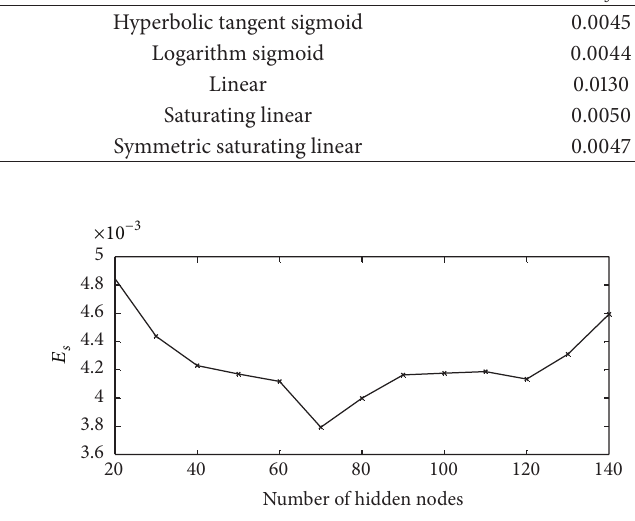
Figure 5: Network validation performance as a function of the number of hidden nodes.